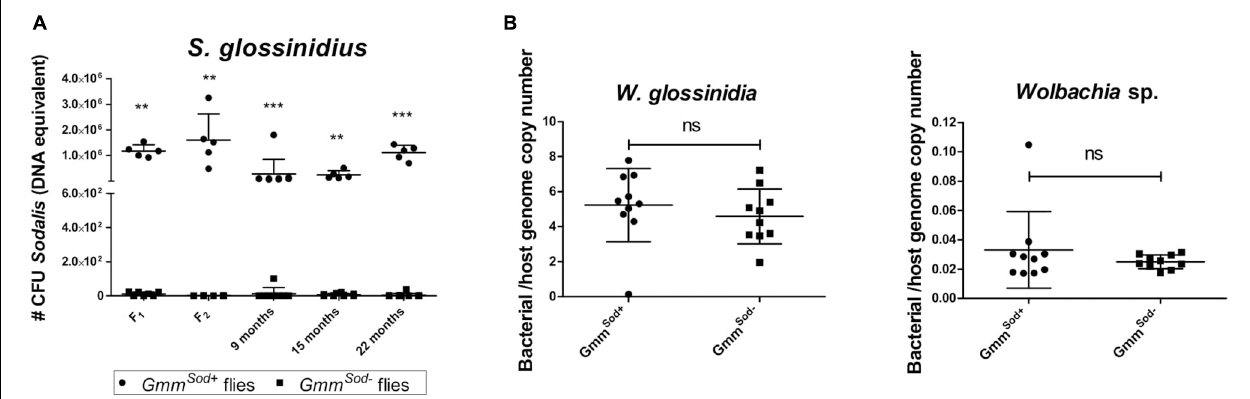
FIGURE 1 | Tsetse fly’s bacterial symbiont densities in offspring flies collected from tsetse females treated with 0.5 µ g/mL streptozotocin. (A) Building-up the Gmm Sod − tsetse fly colony using Sodalis glossinidius -free flies; flies were further maintained on a normal feeding regime. The S. glossinidius density was determined using a standard curve-based S. glossinidius -specific qPCR assay on DNA isolated from 10-day old male abdomens (F 1 and F 2 ) and monitored at a 2-week interval in teneral male abdomen of the Gmm Sod − colony (illustrated by 3 representative timepoints; indicated as months after the females’ F 0 treatment). N = 10 Gmm Sod − independent replicates and N = 5 Gmm Sod + independent replicates per time point. (B) The Wigglesworthia glossinidia and Wolbachia sp. densities were defined as the bacterial genome copy number over the tsetse host genome copy number ( α -tubulin ) and obtained using species-specific qPCR assays. N = 10 independent replicates per group. Values show the bacterial density in each abdomen and are represented as the mean with standard deviation. ∗∗ p -value < 0.01; ∗∗∗ p -value < 0.001; ns: not significant.